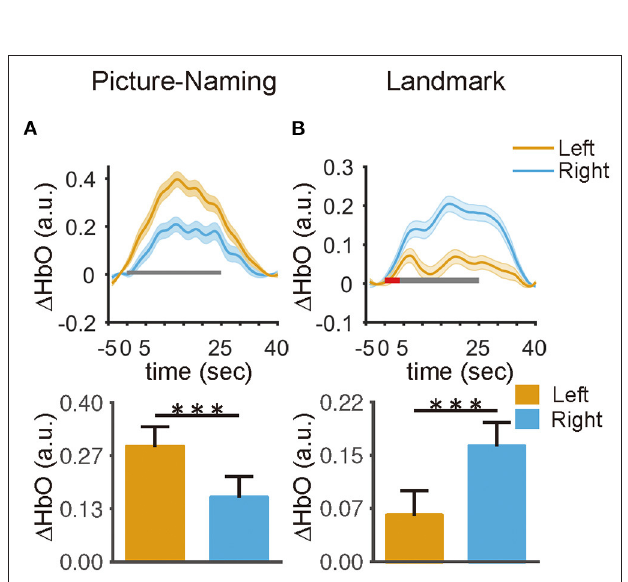
FIGURE 4 | The hemispheric differences in the averaged hemodynamic responses within the ROIs. (A) The left ROI exhibited a larger response than the right ROI in the picture naming task ( t = 5.3, p < 0.001). (B) The right ROI exhibited a larger response than the left ROI under the landmark condition in the landmark task ( t = 6.6, p < 0.001). The red and black rectangle represents the duration of the instruction and task period, respectively. The error bar represents a 95% confidence interval. * p < 0.05, ** p < 0.01, *** p < 0.001.